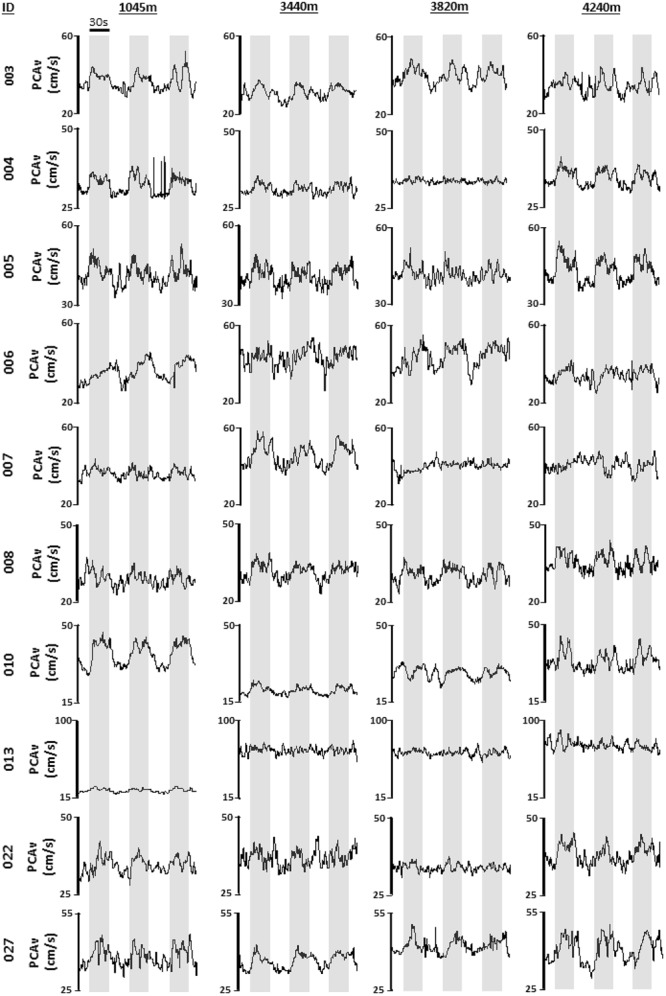
Individual mean PCAv. Original tracings of derived mean PCAv for each participant, during each visual stimulation (VS) trial, at each altitude are provided. Mean PCAv is presented along the y-axis with time presented along the x-axis. Gray shaded regions denote thirty second periods of VS.